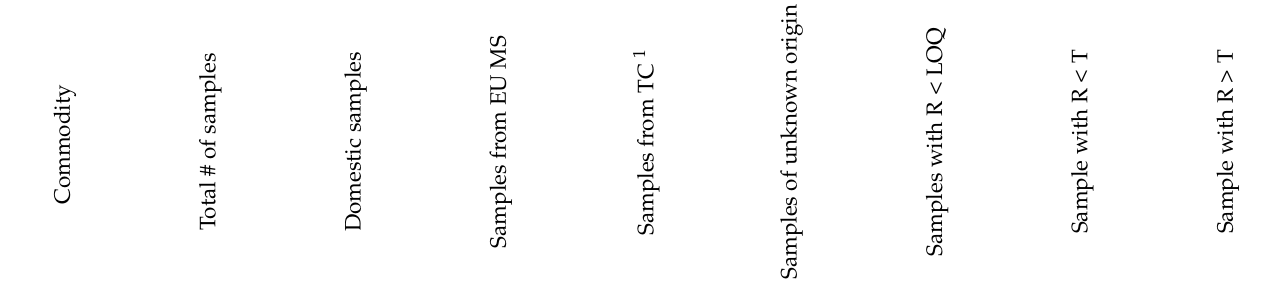
Table A9. Distribution [%] of samples according to origin.